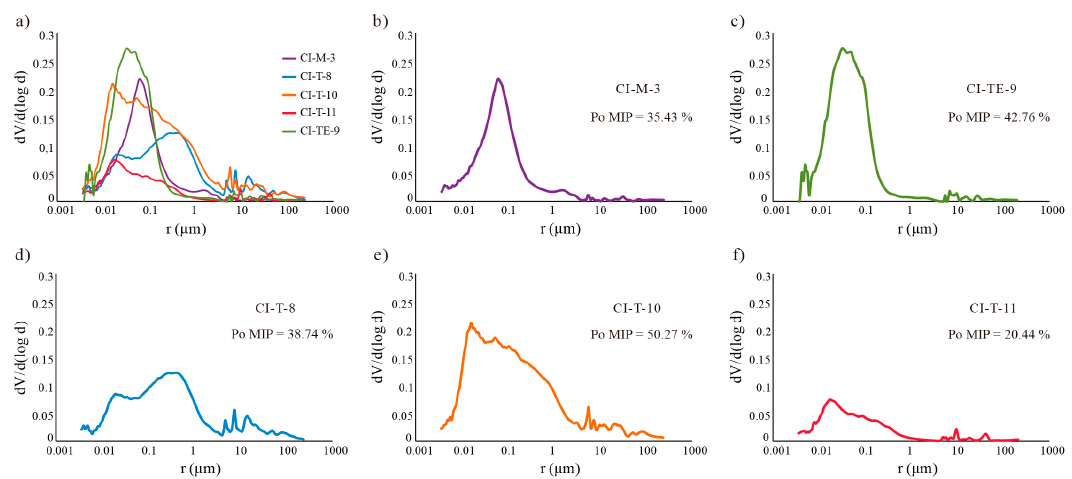
Figure 5. Mercury intrusion porosimetry pore size distribution curves for Irulegi Castle lime mortars: ( a ) all samples, ( b ) CI-M-3, ( c ) CI-TE-9, ( d ) CI-T-8, ( e ) CI-T-10, ( f ) CI-T-11). Pore radius (in µm) is represented versus incremental pore volume (in cm 3 /g).